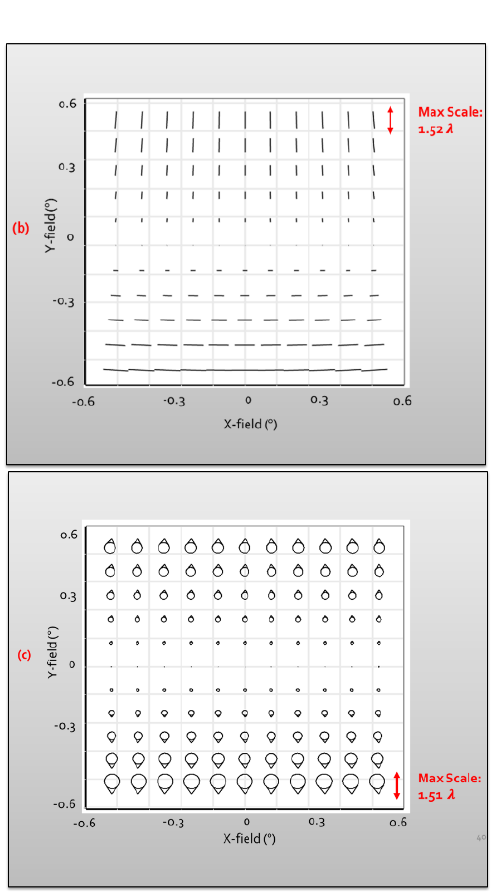
Figure 7. FFDs of the off-axis TMA for the third-order: (a) spherical aberration, (b) astigmatism, (c)